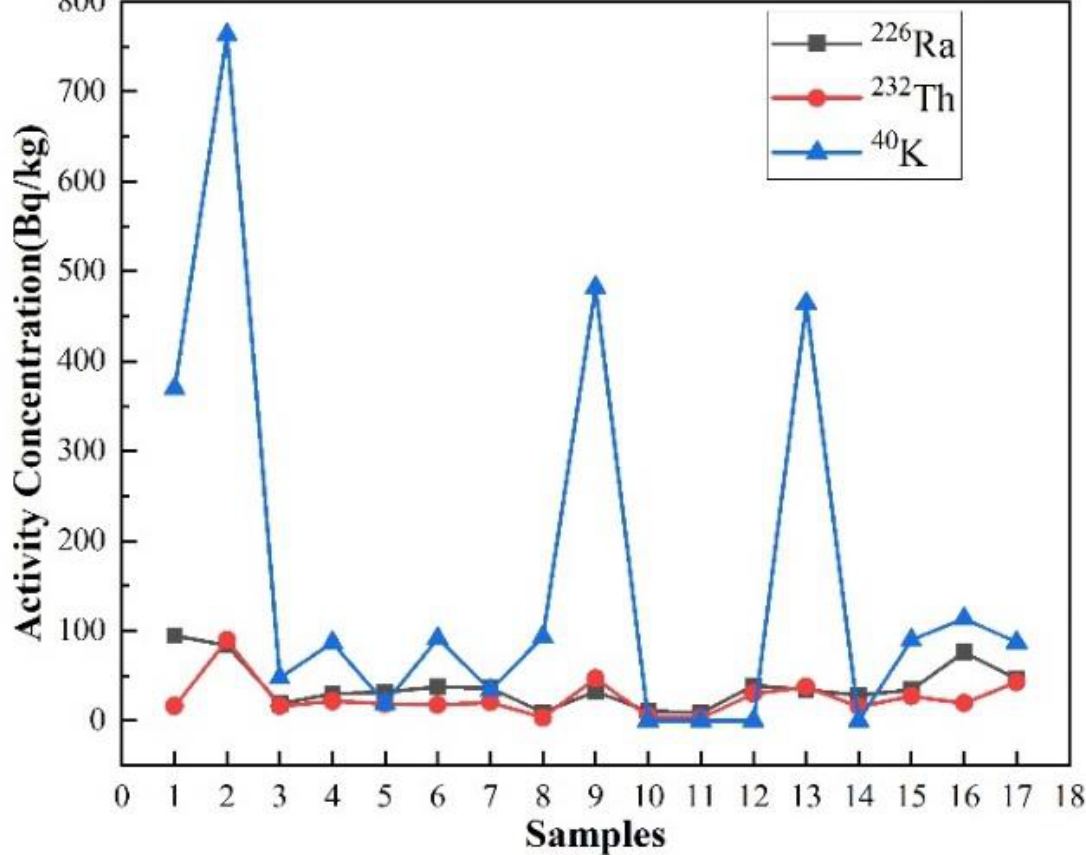
Figure 3. Specific activities of 226 Ra, 232 Th, and 40 K in 17 mining areas.